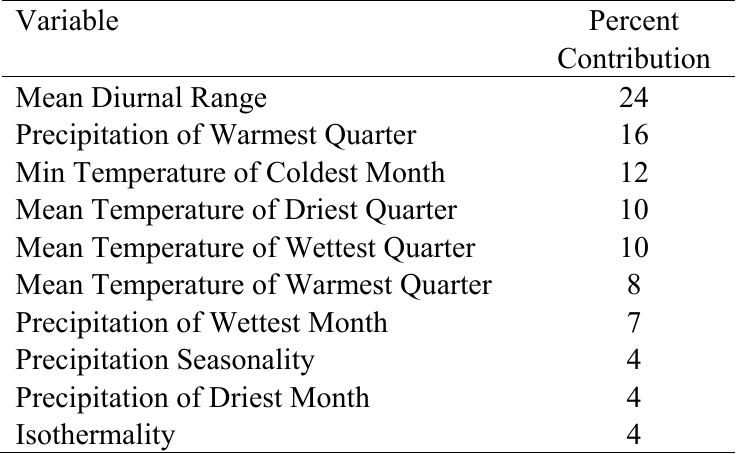
Table 1. Top predictors by percent contributed to the